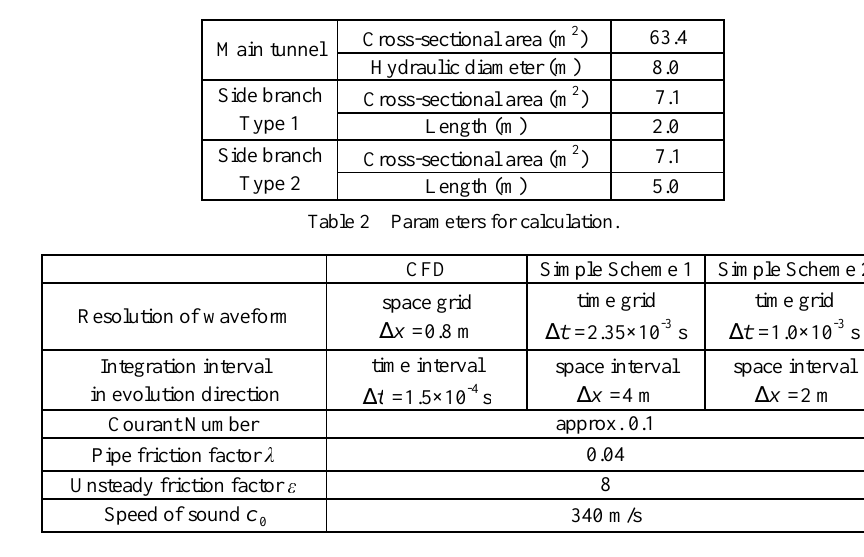
Table 1 Parameters of the concrete slab track tunnel.